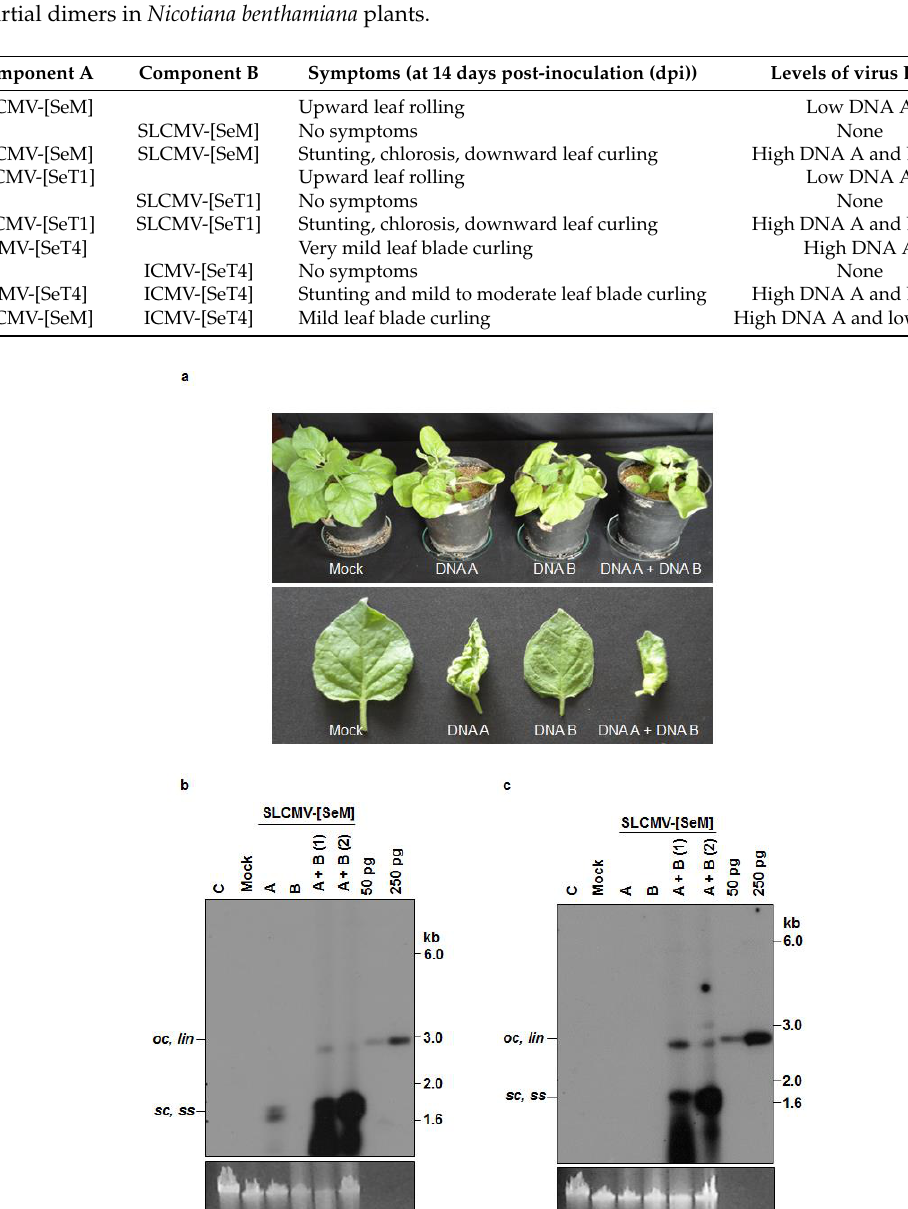
Figure 3. Infectivity analysis of SLCMV-[SeM] partial dimers in N. benthamiana plants. ( a ) Symptoms displayed by N. benthamiana plants agroinoculated with the SLCMV-[SeM] partial dimers. Bottom half shows individual leaves of the tested plants. ( b ) Southern blot analysis using SLCMV-[SeM] DNA A (without common region, ∆ CR) labeled with [ α - 32 P]dCTP as the probe. The plasmid pBS-SLCMV-Ma-A digested with PstI (50 pg and 250 pg) was used as the positive control. ( c ) Southern blot analysis using [ α - 32 P]dCTP-labeled SLCMV-[SeM] DNA B ( ∆ CR) as the probe. The plasmid pBS-SLCMV-Ma-B digested with BamHI (50 pg and 250 pg) was used as the positive control. ( b , c ) DNA (1 µ g) from uninfected plant (C), plant mock infected with the Agrobacterium tumefaciens strain Ach5 (Mock), plant agroinoculated with partial dimers of DNA A alone (A), DNA B alone (B) and two plants independently co-agroinoculated with the partial dimers of DNA A + DNA B (A + B) were loaded in the respective lanes. Positions of different forms of viral DNA, single stranded ( ss ), super-coiled ( sc ), open circular ( oc ) and linear ( lin ), are marked. Ethidium bromide stained high molecular weight plant DNA is shown as loading control at the